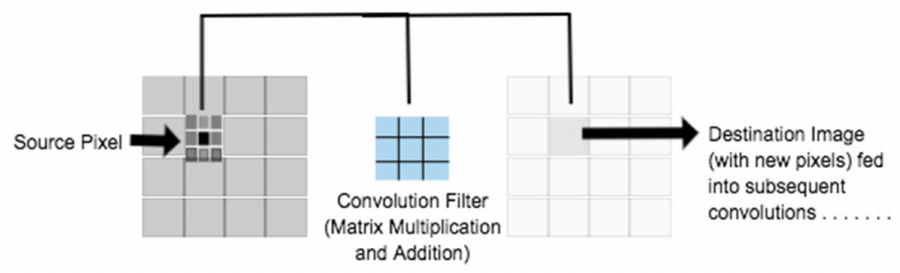
Figure 4. Feature learning and convolution (Adapted from https://towardsdatascience.com/applied-